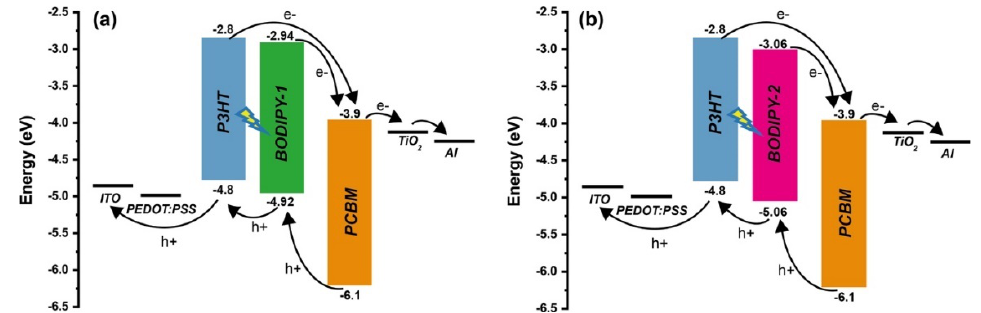
Figure 7. Energy alignment diagram of active material in ternary solar cells. ( a ) BODIPY-1 :P3HT:PCBM and ( b ) BODIPY-2 :P3HT:PCBM.